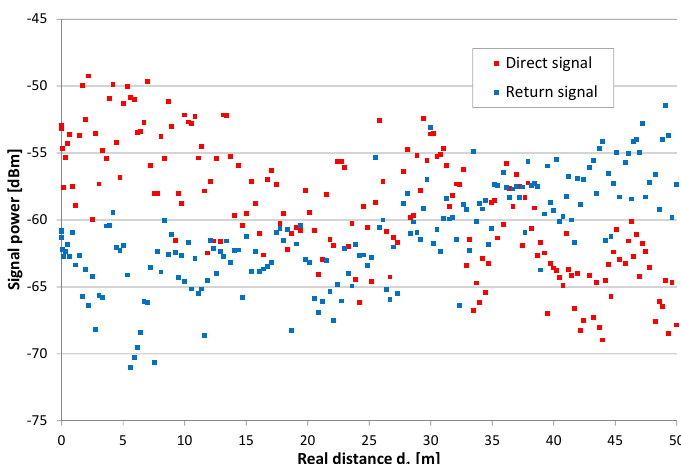
Figure 17. Exemplary values of the power level of direct and return signal, series 12.